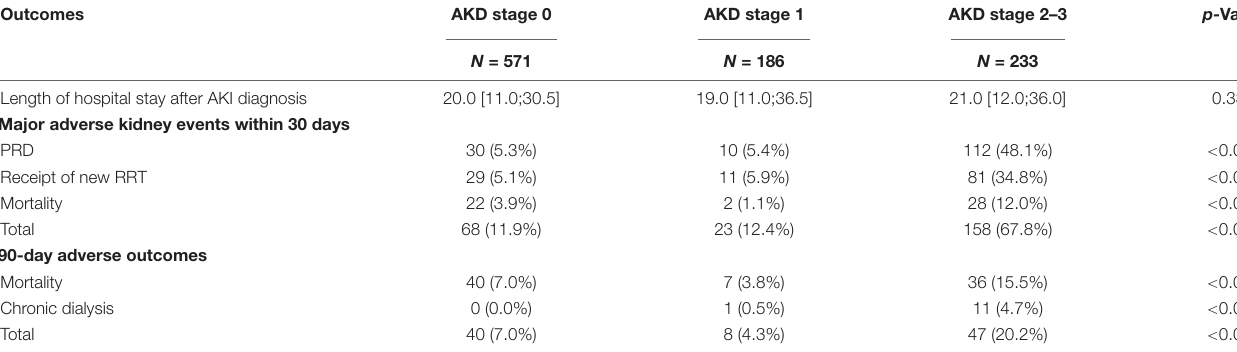
TABLE 2 | Outcomes of the study population stratified by AKD stage.